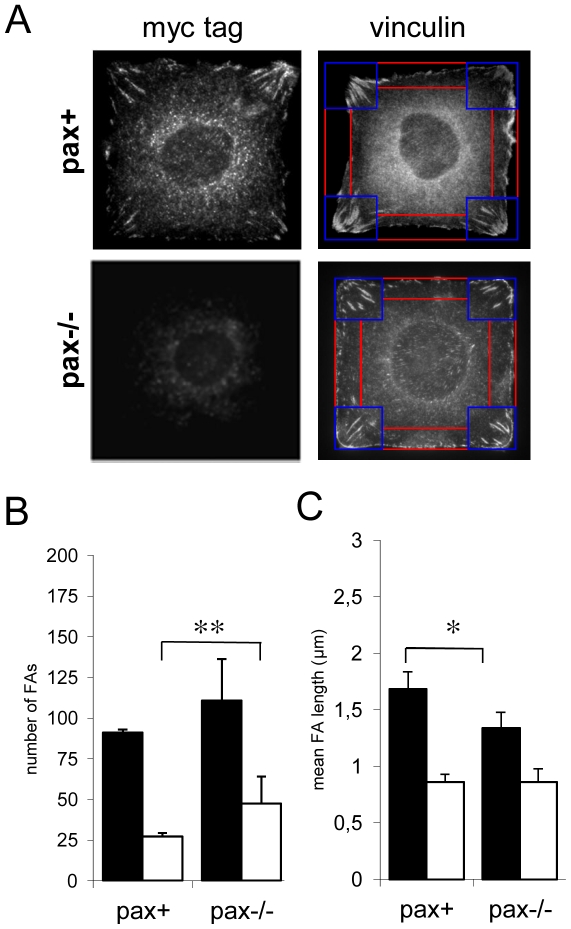
The number and distribution of vinculin-containing adhesive complexes is abnormal in paxillin knockout cells.A) Myc-tagged paxillin is localized to predominantly corner-localized FAs in pax+, but not pax−/−, cells (left). Both pax+ and pax−/− cells show FAs as detected by immunostaining for vinculin (right), but pax−/− cells have more adhesive structures in side regions (red) and fewer long, fibrillar type adhesions in corner regions (blue). B) Quantification of number of FAs in corner (black bars) and side regions (white bars). n>6 cells, 400 FAs per genotype. ** p<0.005. C) Quantification of FA length in corner (black bars) and side regions (white bars). * p<0.05.